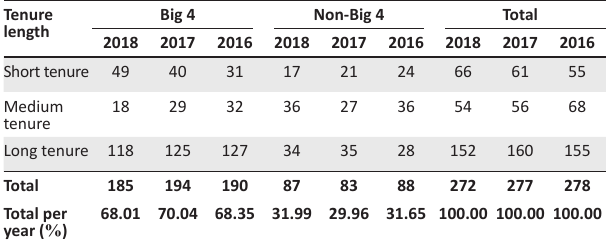
TABLE 6 : Number of clients per audit firm tenure length and audit firm size (2016–2018).